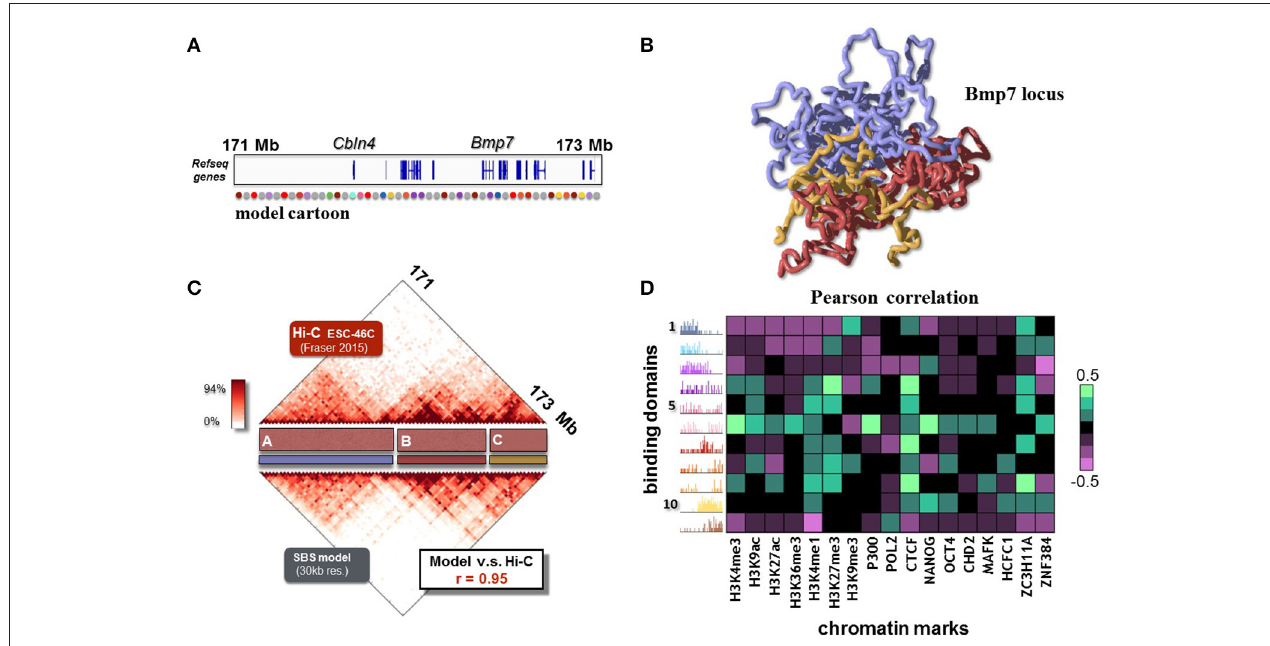
FIGURE 4 | The folding of the Bmp7 locus in ESC-46 cells is recapitulated by the SBS model. (A) The modeled 2.3Mb region around Bmp7 gene (chr2:171090000-173430000, mouse ESC-46C cells) is shown. A schematic representation of the SBS polymer model is reported in the bottom part. (B) 3D reconstruction from a Molecular Dynamics simulation of the Bmp7 locus. It allows to visualize how TADs and higher-order metaTAD structures fold in space for this locus (adapted from Chiariello et al., 2016). (C) The SBS model recapitulates the experimental Hi-C data (binned at 30Kb resolution, from Fraser et al., 2015) with good accuracy, as shown by the simulated contact map (Pearson correlation coefficient r = 0.95, adapted from Chiariello et al., 2016). (D) Pearson correlation coefficients between the relative abundance of binding domains with epigenetics chromatin features. The resulting barcode of the binding domains predicted by the SBS model links epigenetics to spatial architecture, and returns a potential map of the molecular nature of the factors driving folding.